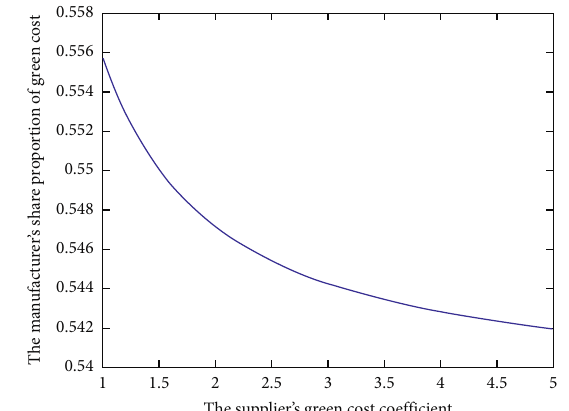
Figure 4: Comparing the green level of the supplier in the cases of a single supplier and a cooperative.